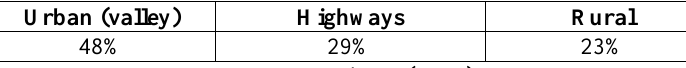
Figure 15: Road densities. Table 23: National accident data by road category.